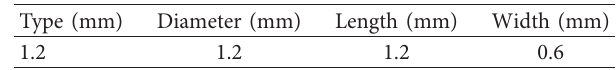
Figure 4: Constitutive relations of the mooring lines. Table 2: Parameters of mooring line.